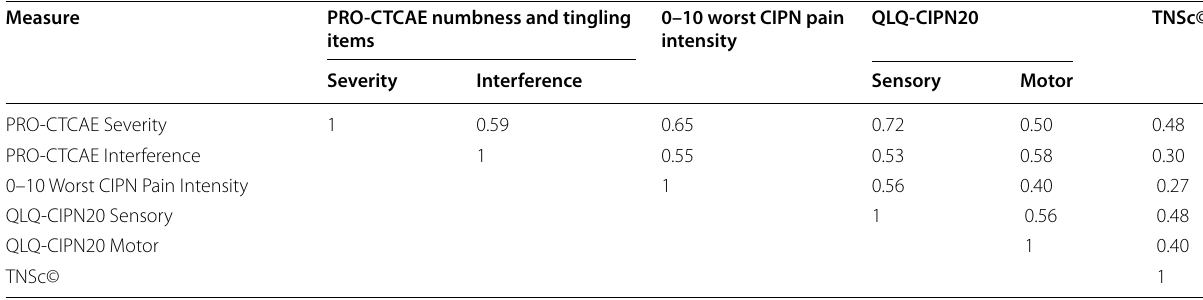
Table describes correlations among the PRO-CTCAE Numbness and Tingling Severity and Interference Items, QLQ-CIPN20, 0–10 worst CIPN pain intensity NRS ( n 138), and TNSc© ( n 118) at T3 = = CIPN-Chemotherapy-Induced Peripheral Neuropathy, PRO-CTCAE ™ —Patient-Reported Outcomes Version of the Common Terminology Criteria for Adverse Events, QLQ-CIPN20-Quality of Life Questionnaire-Chemotherapy-Induced Peripheral Neuropathy Scale, TNSc©—Total Neuropathy Score-Clinical